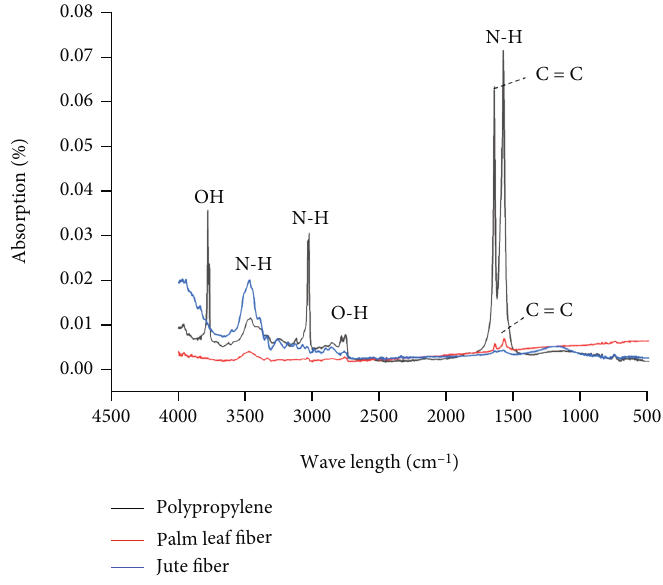
Figure 1: FTIR spectra of polypropylene, jute, and palm leaf fi bers.